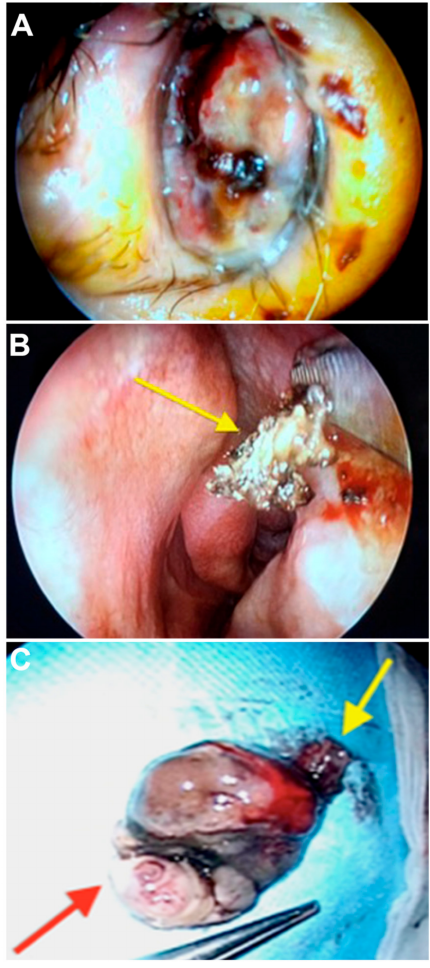
Figure 3. ( A ) Endoscopic examination revealed a purplish-colored polypoid neoformation that obliterates 70% of the left nostril. ( B ) After mass excision, the neoformation attack site was identified on the inferior turbinate head (arrow) and cauterized. The entire nasal mucosa of the same cavity appears macroscopically clean and free of neoplastic infiltration. ( C ) The neoformation was extracted en bloc, with a diameter of about 4 cm. The yellow arrow indicates the insertion pedicle. The red arrow indicates the part obliterating the